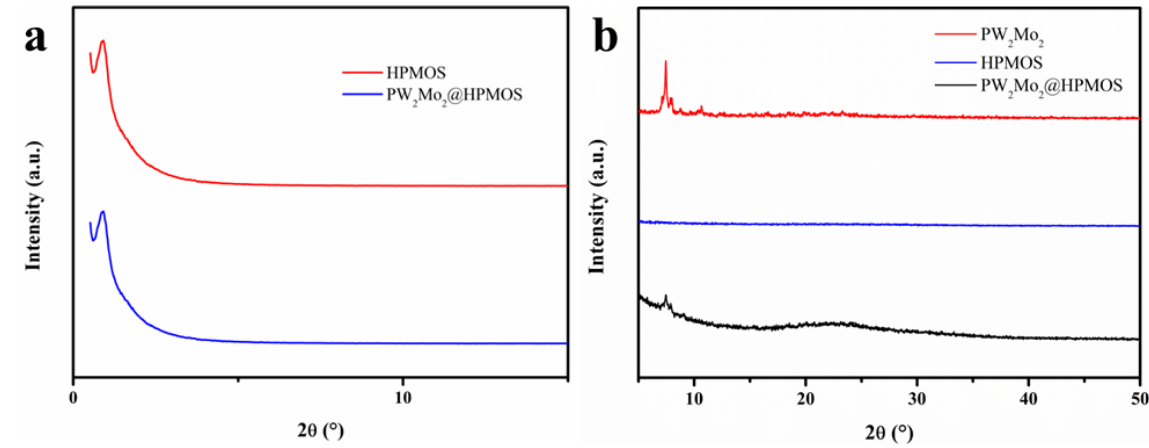
Figure 2. Low-angle ( a ) and high-angle ( b ) XRD patterns of prepared materials.